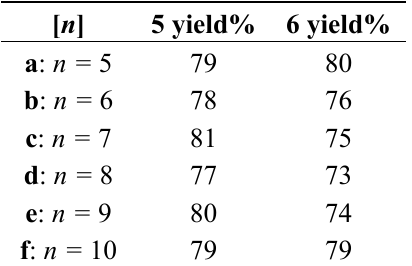
Table 3. Hydrogenation of compound 2 to afford product 5 and 6 .